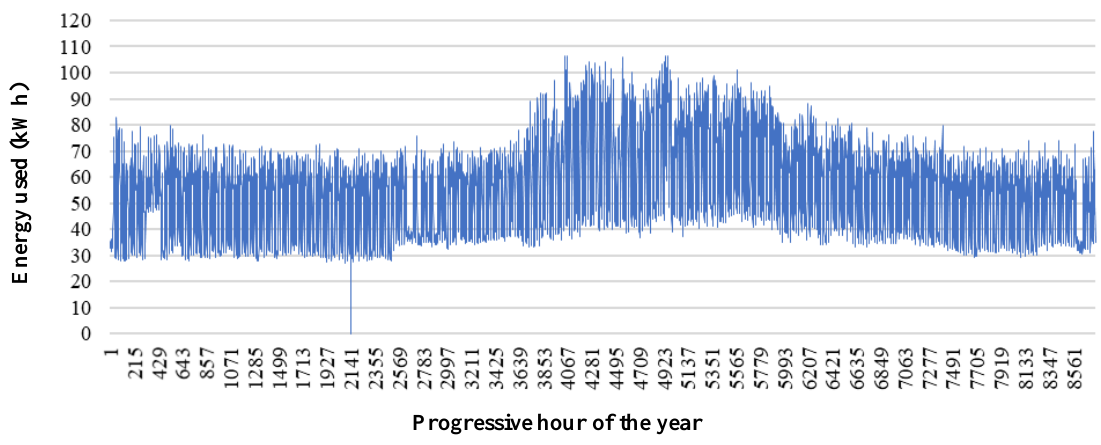
Figure 3. Hourly trend of energy consumption for the higher size supermarket (for Store B).